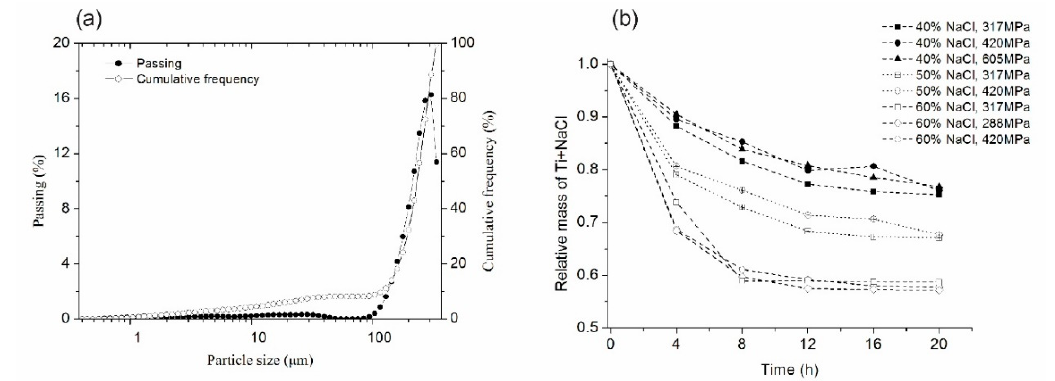
Figure 2. ( a ) Particle size distribution of NaCl used as a space holder and ( b ) relative mass loss of Ti+NaCl as a function of dissolution cycles in distilled water at 60 °C.